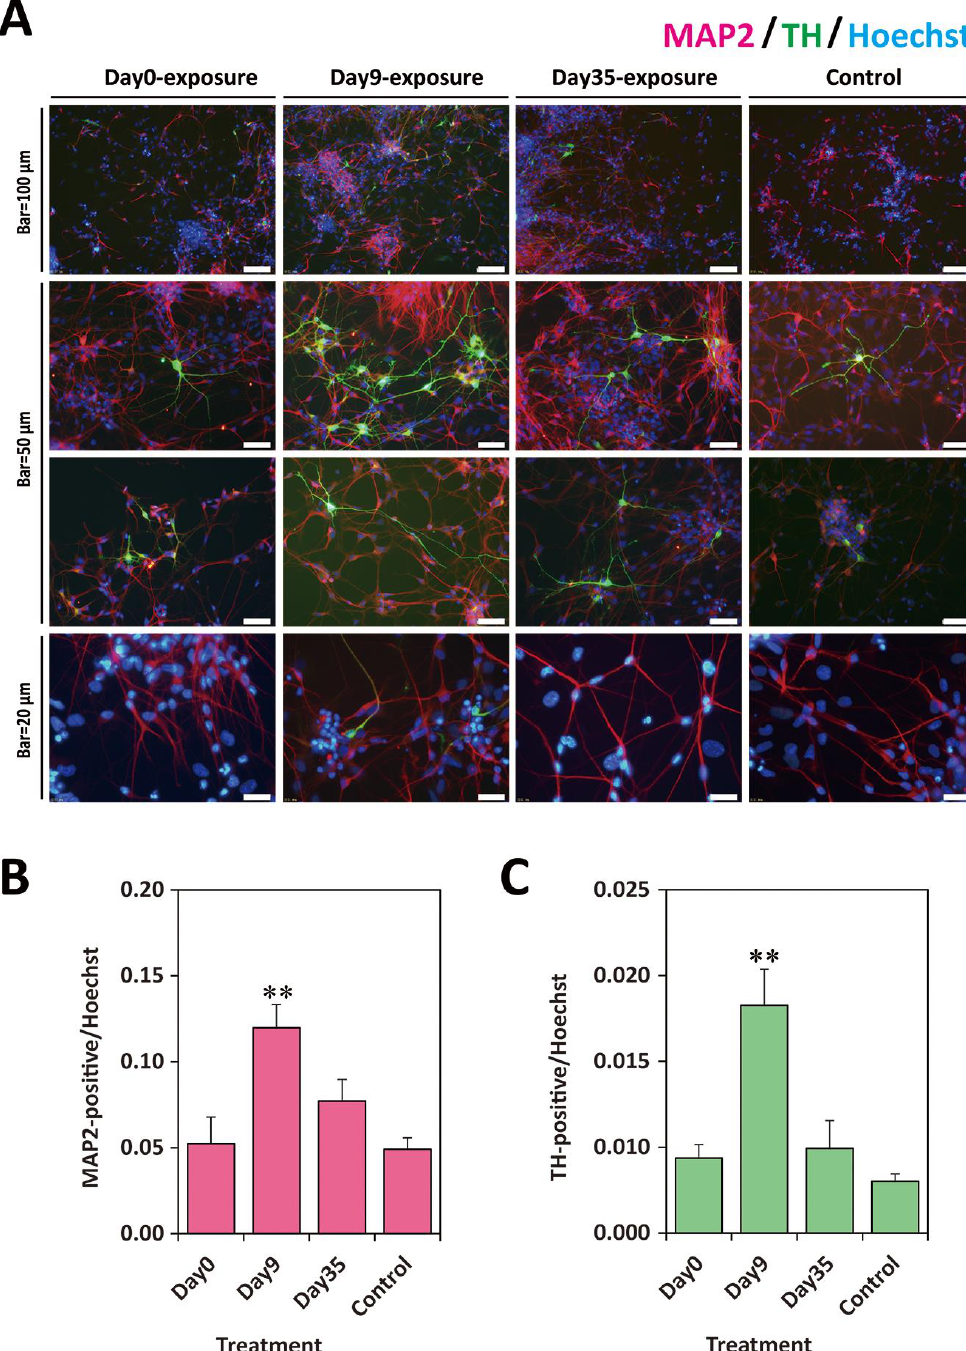
Figure 4. ICC analysis on Day40 of cells exposed to TCDD at different stages of differentiation. ( A ) Typical microscopy images of neural cells derived from KhES1 on Day40. Day0-exposure group, the cells exposed to 10 nM TCDD from Day0 for 24 h; Day9-exposure group, the cells exposed to 10 nM TCDD from Day9 for 24 h; Day35-exposure group, the cells exposed to 10 nM TCDD from Day35 for 24 h; Control, the cells differentiated following the same protocol without treatment. Red, MAP2-immnostaining; Green, TH-immunostaining; Blue, nucleus stained with Hoechst 33342. ( B ) Ratio of MAP2-positive cells in the culture. The y -axis indicates the number ratio of MAP2-positive cells per Hoechst counts. ( C ) Ratio of TH-positive cells in culture. The y -axis indicates the numbers ratio of TH-positive cells per Hoechst counts. Data from four images per group are expressed as mean ± SE. One-way ANOVA was carried out followed by Dunnett’s test as post hoc (**, p <